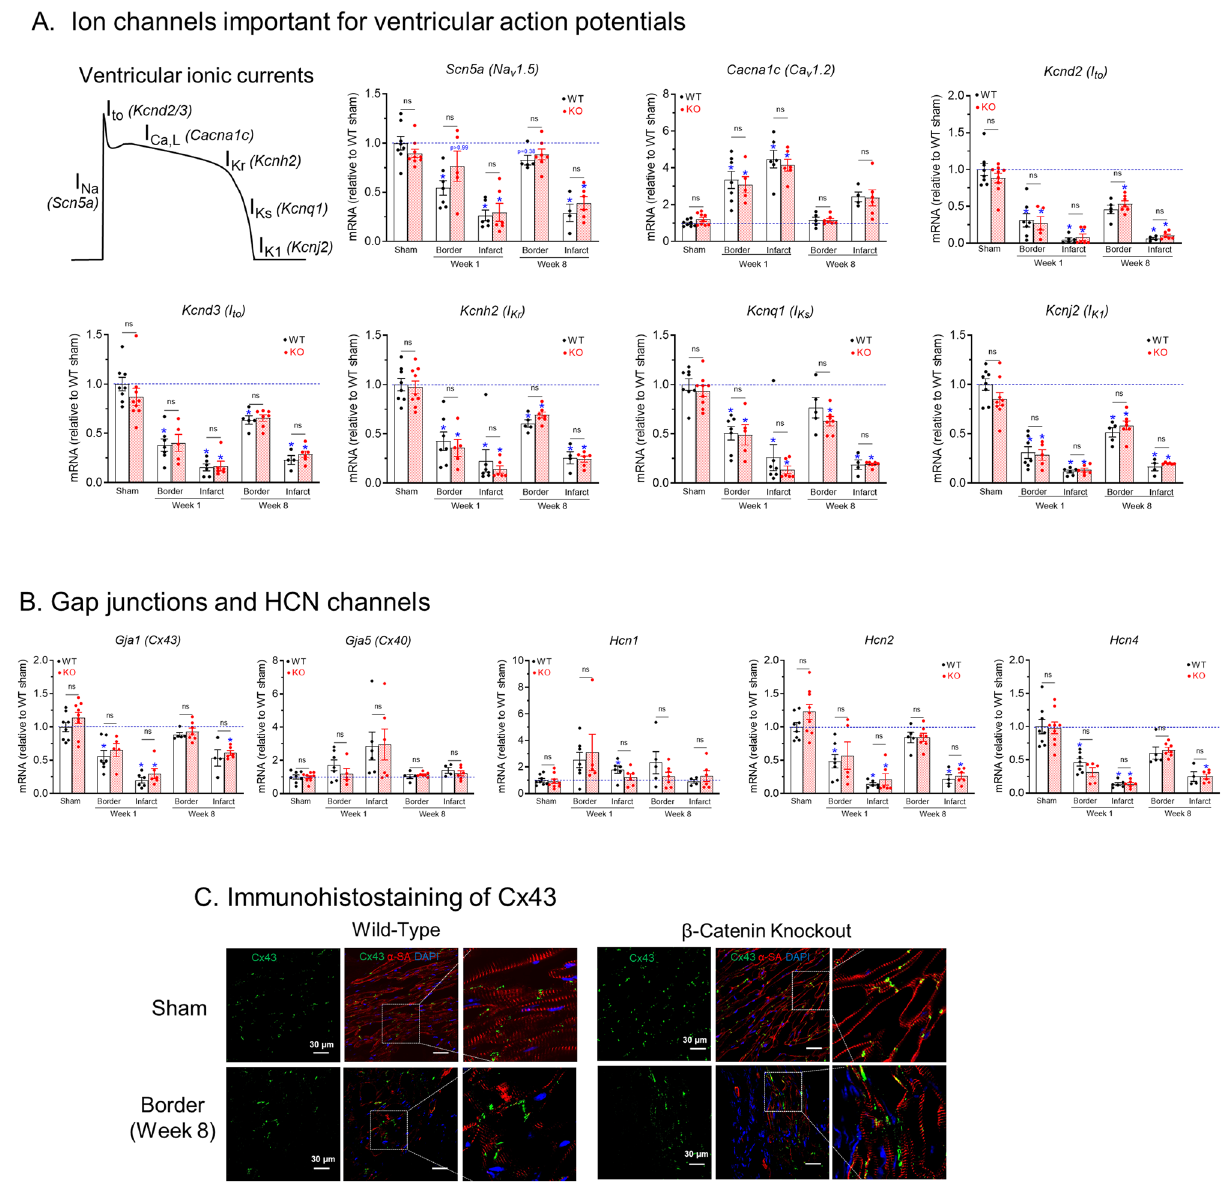
Figure 8. Ion channel gene expressions after myocardial infarction. ( A ) and (B) qRT-PCR analyses of transcript levels of ion channels involved in ventricular action potentials ( A ), and gap junctions and HCN channels ( B ) in sham, 1-week post MI, and 8-week post MI infarct and border zone myocardium. n = 4–10 per group. * p < 0.05 vs. corresponding sham groups. “ns” means no significant difference between WT and KO groups. Data were analyzed by two-way ANOVA and Bonferroni post-hoc comparison. Abbreviations in panel A: I Na , cardiac sodium current; I to , transient outward potassium current; I Ca,L , L-type calcium current, I Kr , rapidly activating delayed rectifier potassium current; I Ks , slowly activating delayed rectifier potassium current; I K1 , inwardly rectifying potassium current. ( C) Representative confocal images showing similar distribution patterns of Connexin 43 (Cx43, green) in WT and KO myocardium. In sham hearts (top panels) of both WT and KO groups, Cx43 is restricted to the cell–cell junctions. In the border zone of hearts at 8-week after MI (bottom panels), both WT and KO groups showed a more diffusive pattern for Cx43. Cells were co-stained with α-sarcomeric actinin (α-SA, red color, a marker of cardiomyocytes) and DAPI